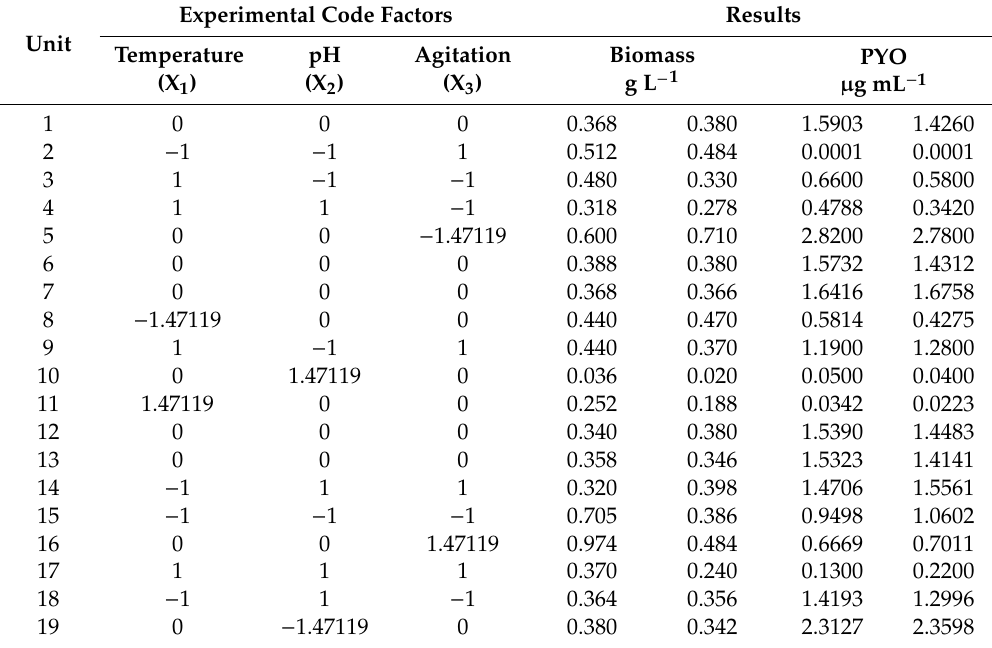
Table 1. Experimental central composite design matrix; biomass and pyocyanin (PYO) experimental